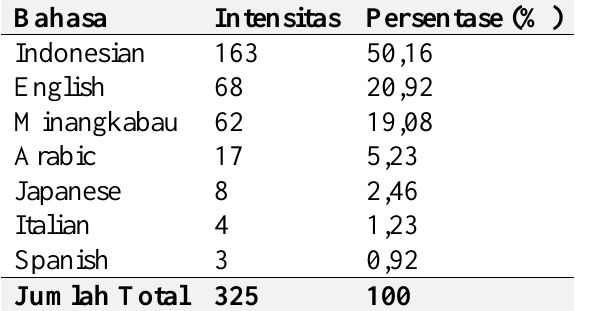
Table 5. Intensity of language use in